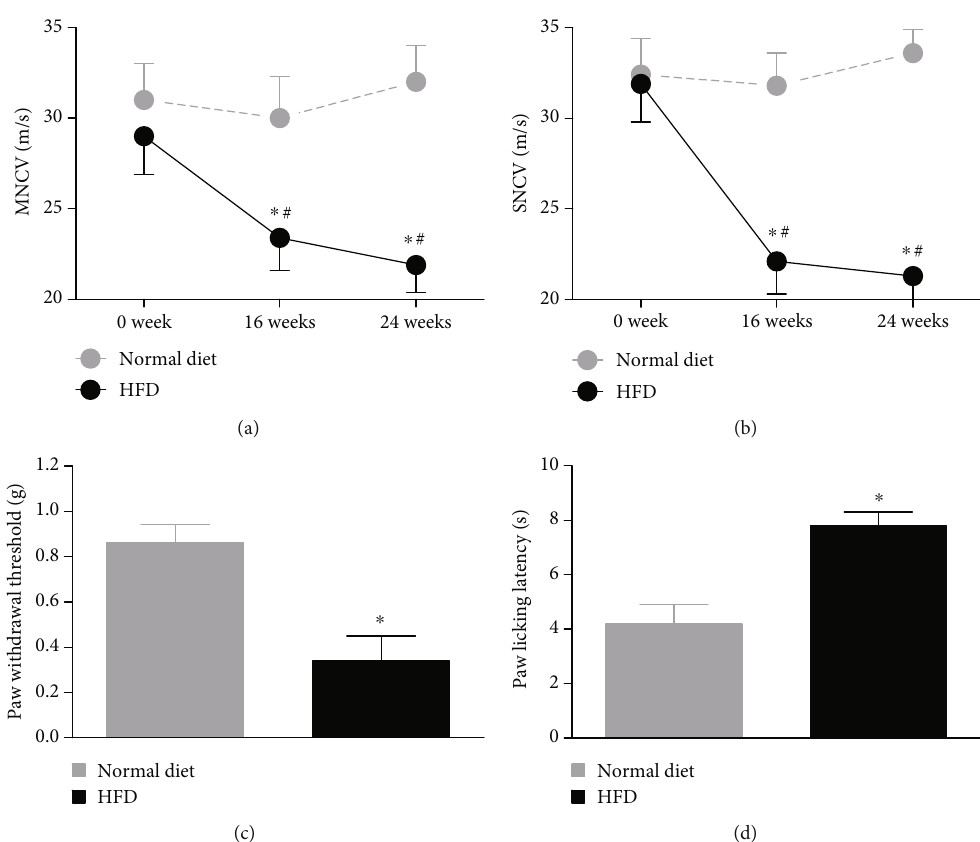
Figure 1: E ff ects of HFD treatment on neuropathy in mice. HFD-fed mice exhibited (a) motor nerve conduction velocity (MNCV), (b) sensory nerve conduction velocity (SNCV), (c) tactile allodynia, and (d) thermal hypoalgesia ( n = 10/group ). Asterisks represent the signi fi cant di ff erence relative to normal diet control ( p < 0 : 05 ). Pounds represent the signi fi cant di ff erence relative to week 0 ( p < 0 : 05